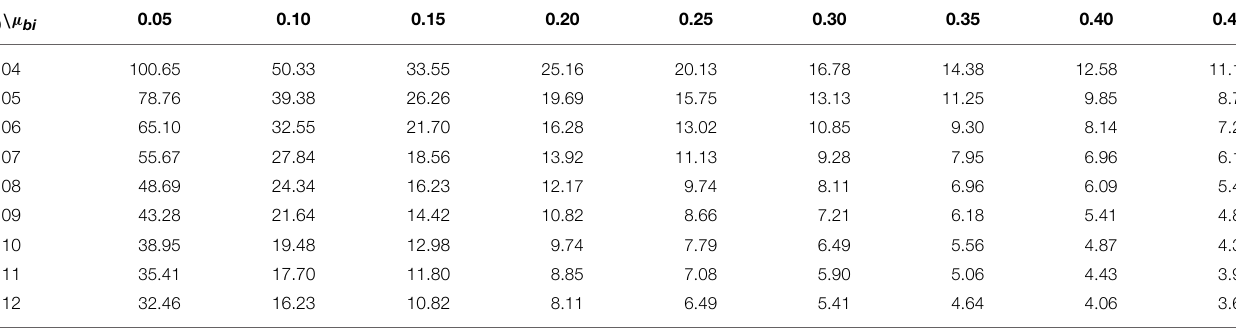
TABLE 1 | Effect of different settings of parameters f 0 and µ bi on the speed selectivity (in pixel / s ), i.e., f 0 t / f 0 x , with f 0 x and f 0 t maximizing |ˆ F | for σ = 25 . f 0 \ µ